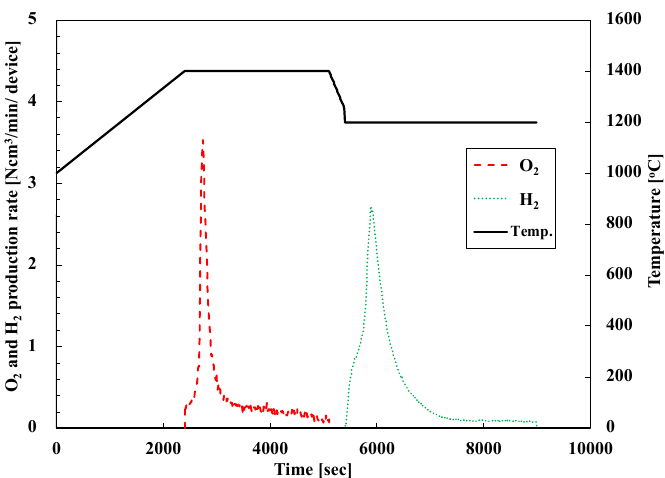
Figure 7. O 2 and H 2 evolution profiles of two-step water-splitting cycle of pristine CeO 2 foam device (PCC10) in the first cycle. Table 3. Experimental result of five cyclic tests, total production amount, and average production amounts for oxygen and hydrogen.